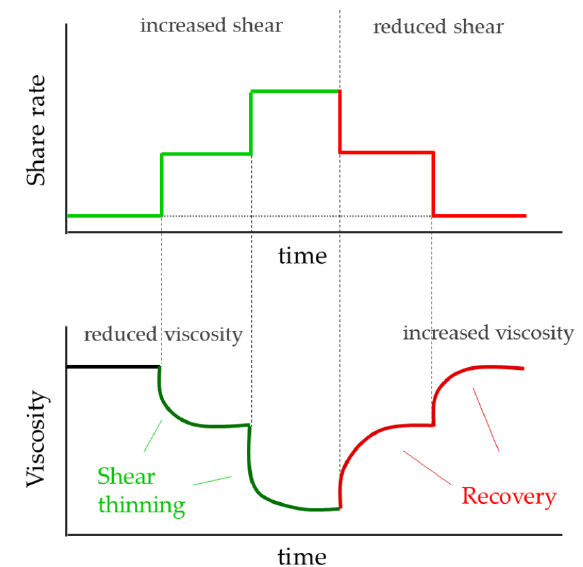
Figure 2. Schematic diagram showing the change in viscosity with time following changes in shear rate to illustrate the thixotropic behavior of semi-solid slurries [11].